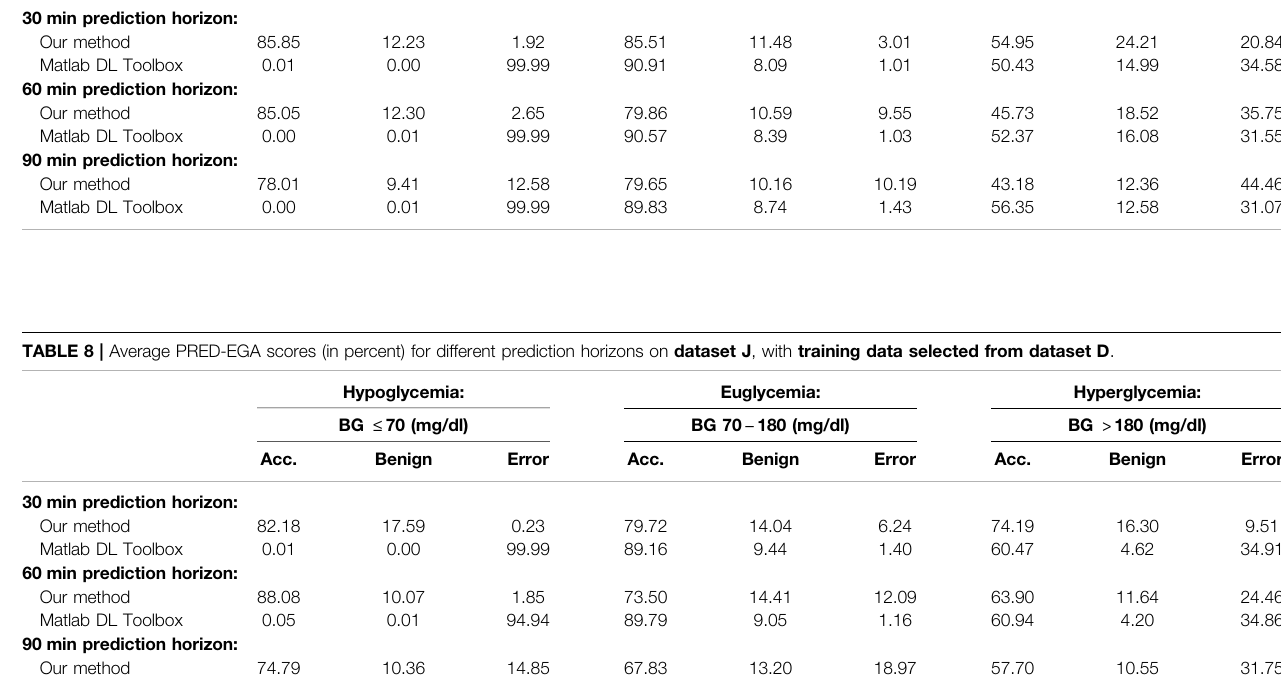
Frontiers in Applied Mathematics and Statistics |